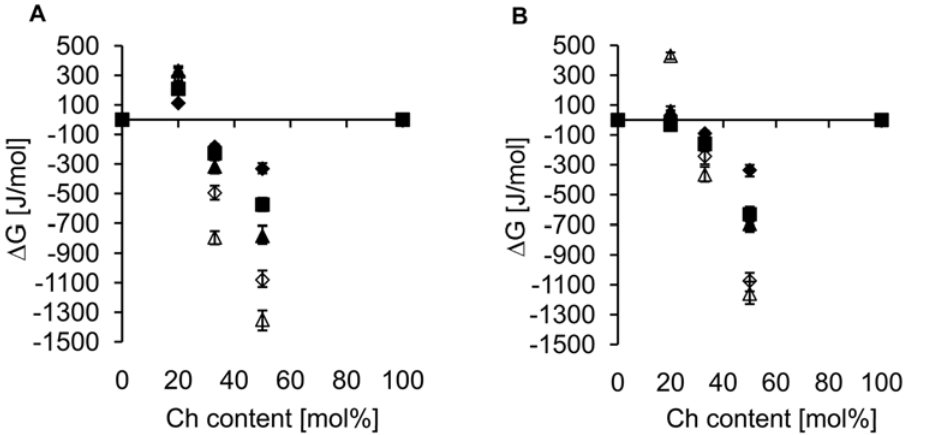
Figure 3. Comparison of D G values for SLPE/Ch monolayers at 4 and 37 u C. Dependence of molar Gibbs excess free energy ( D G) of mixing on cholesterol content in mixed cholesterol/SLPE monolayers at (A) 4 u C and (B) 37 u C. Each point represents an average of several experiments. D G was calculated at surface pressure of ( ¤ )5, ( )10, ( m )15, ( e )20 and ( D )30 mN/m.